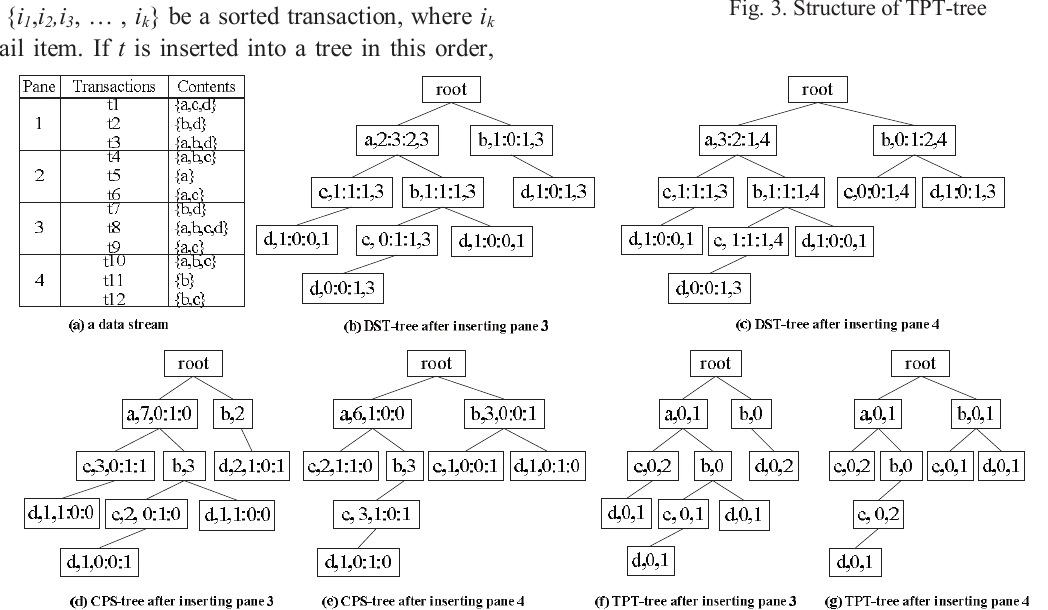
Fig. 3. Structure of TPT-tree